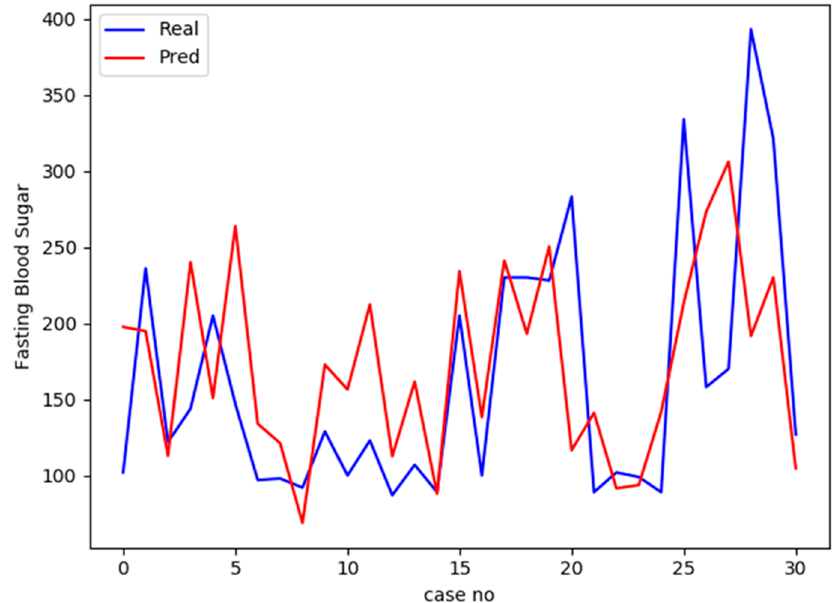
Figure 2. A comparison between the actual fasting blood sugar (FBS) values for and the predicted values the testing group (31 cases) using multilayer feed-forward neural network (FNN) predicting model generated based on the training set. The blue line displays actual values while the red line displays the predicted values. The x -axis represents case number, while y -axis represents the value of FBS for each case.